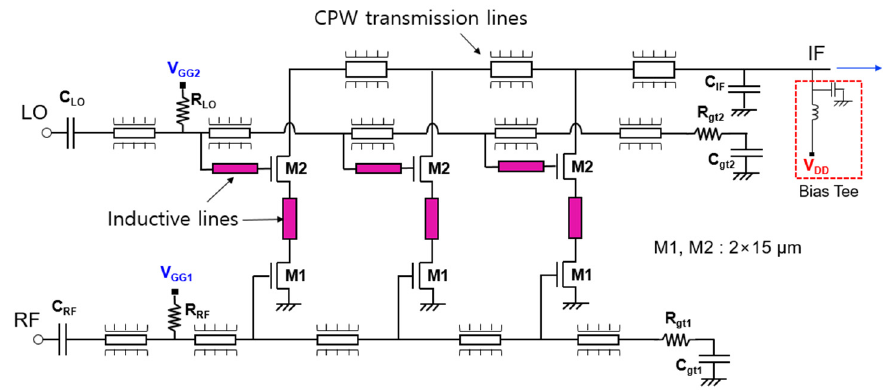
Figure 11. Circuit schematic of distributed cascode mixer.